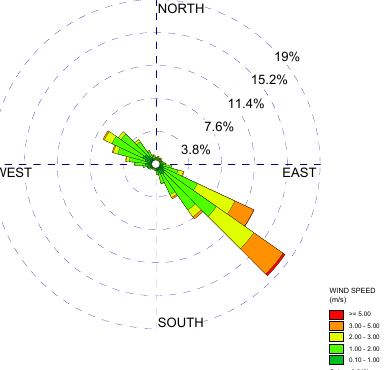
Figure 2. Wind direction and wind speed distribution of SACOL in 2008.